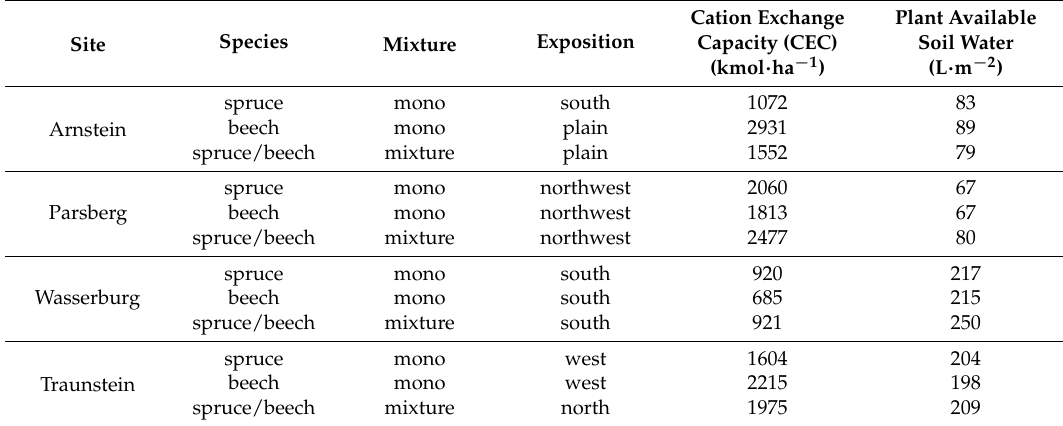
Table 3. Soil characteristics (availability of water and nutrients (cation exchange capacity, CEC)) in the monospecific and mixed stands